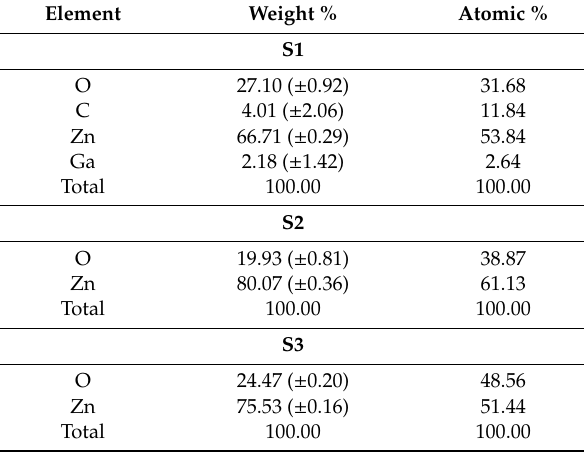
Table 2. EDXMA weight and atomic compositions of individual elements in S1, S2, and S3.